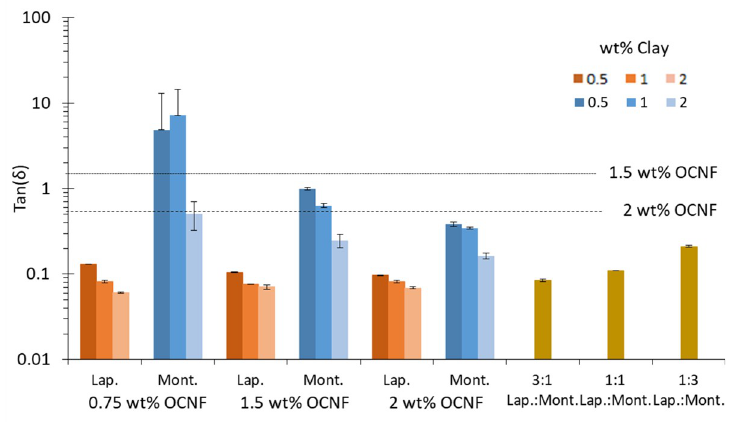
Fig 2. The tan( δ ) values of mixtures of Laponite and montmorillonite with OCNF. The negative error bars of 0.5 and 1 wt% montmorillonite in 0.75 wt% OCNF go beyond zero and are therefore not displayed on a log plot.